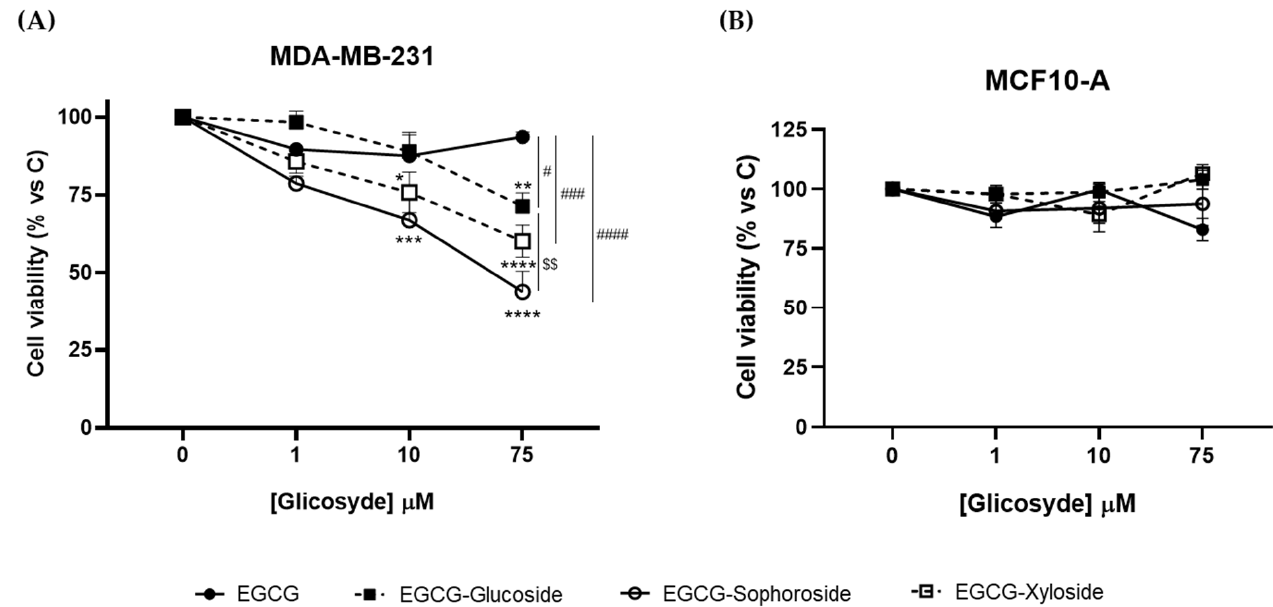
Figure 5. Effect of EGCG and its glycosides on the viability of ( A ) MDA-MB-231 and ( B ) MCF-10A cells after 24 h of compound addition. Cell viability was determined by crystal violet assay. Data represent mean ± SEM of three independent experiments. * p < 0.05, ** p < 0.01, *** p < 0.005, **** p < 0.001 vs. vehicle-treated cells. # p < 0.05, ### p < 0.005, #### p < 0.001 vs. 75 μM EGCG-treated cells. $$ p < 0.01 vs. 75 μM EGCG-Glucoside-treated cells.